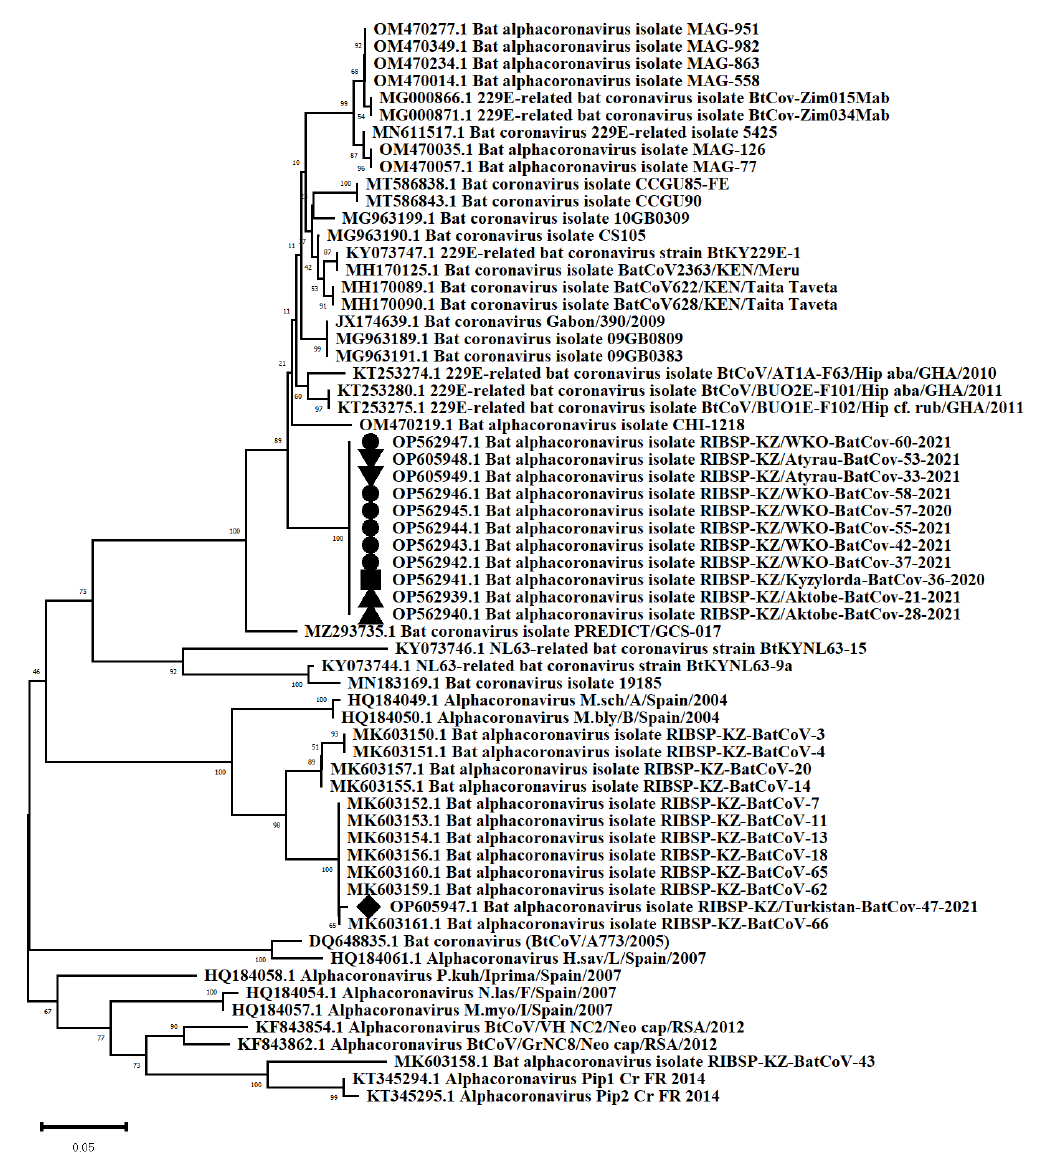
Figure 5. Phylogenetic analysis of the nucleotide gene sequence of RNA-dependent reverse poly- merase (RdRp).